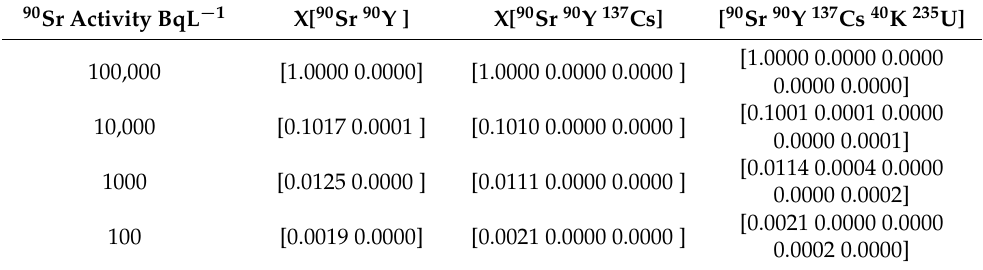
Table 1. Results of analysis of a pure 90 Sr mixture of decreasing activity with different radionuclides included in the detector response matrix.